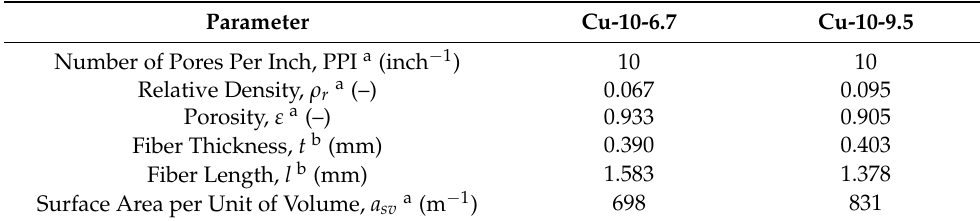
Table 1. Geometrical parameters of the tested copper foams.